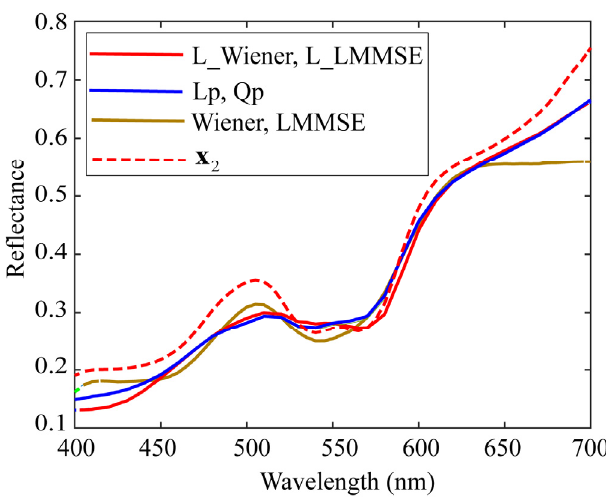
Figure 11. Spectral curves estimated using the four proposed methods for spectral reflectance x 2